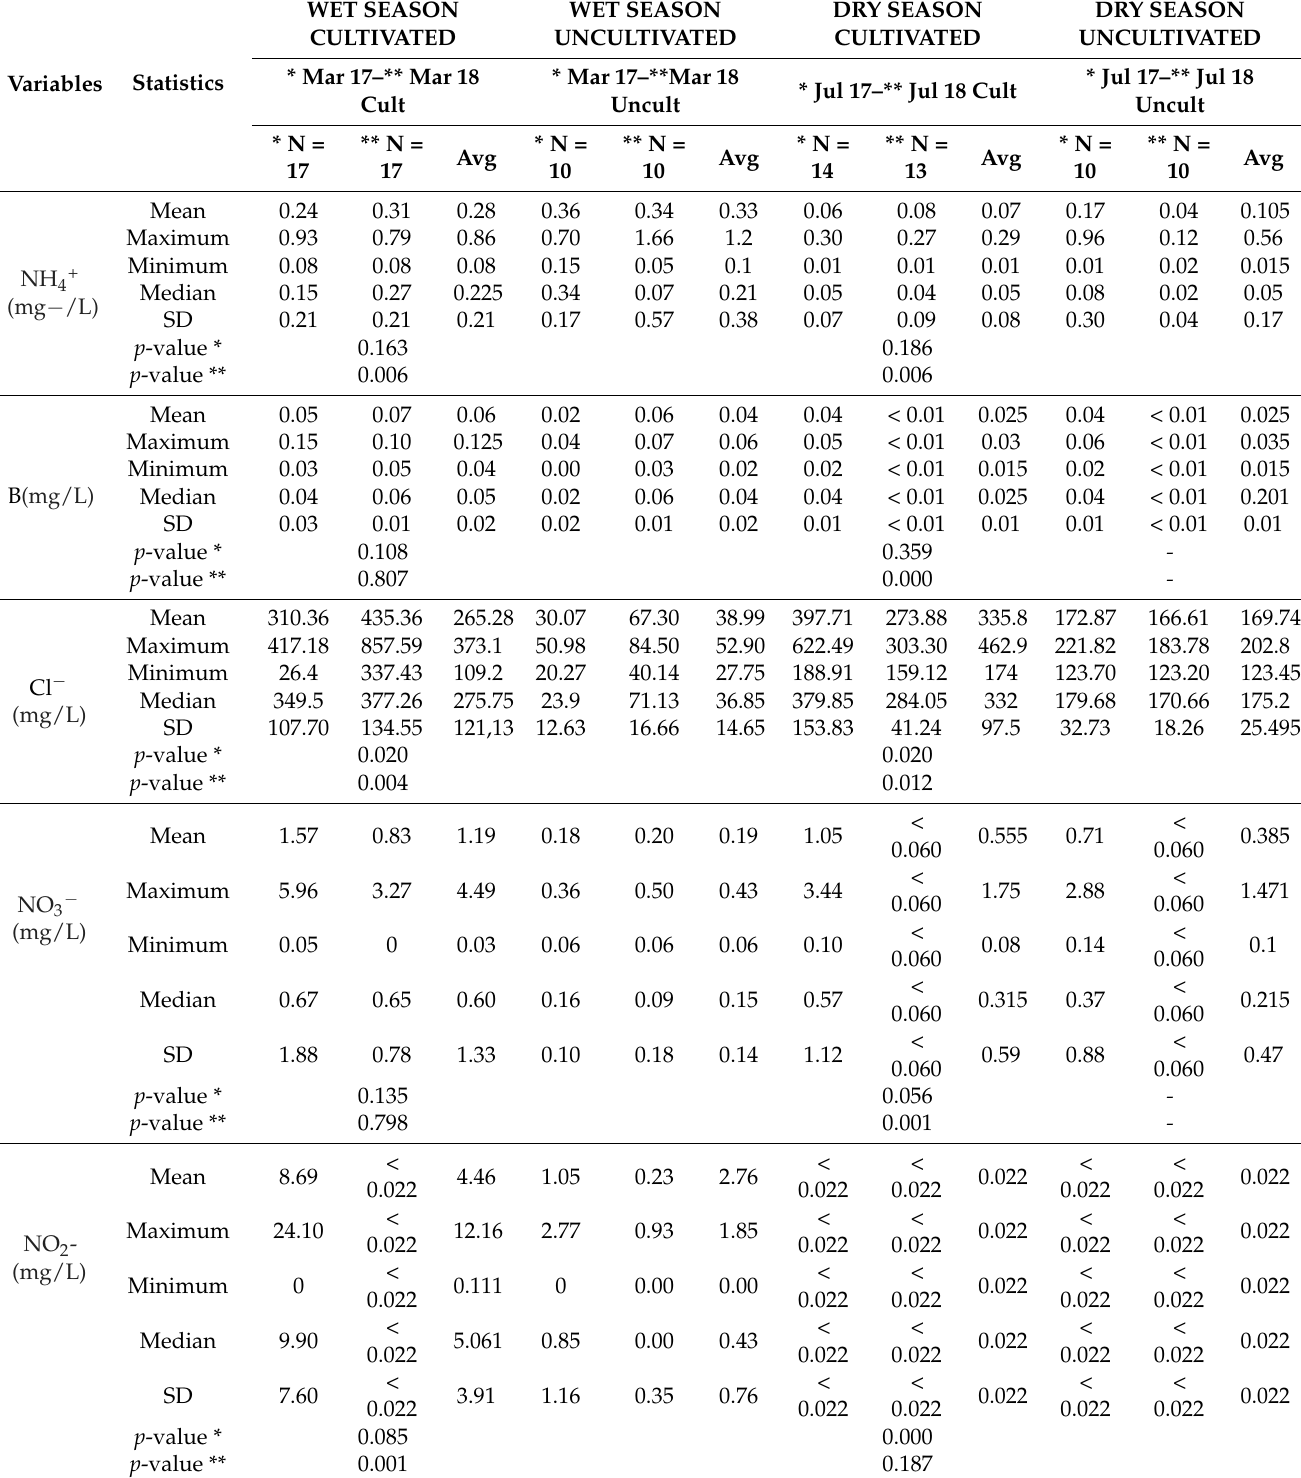
Table 1. Water quality parameters based on the land use (cultivated and uncultivated) for 2017 and 2018 dry and wet periods.